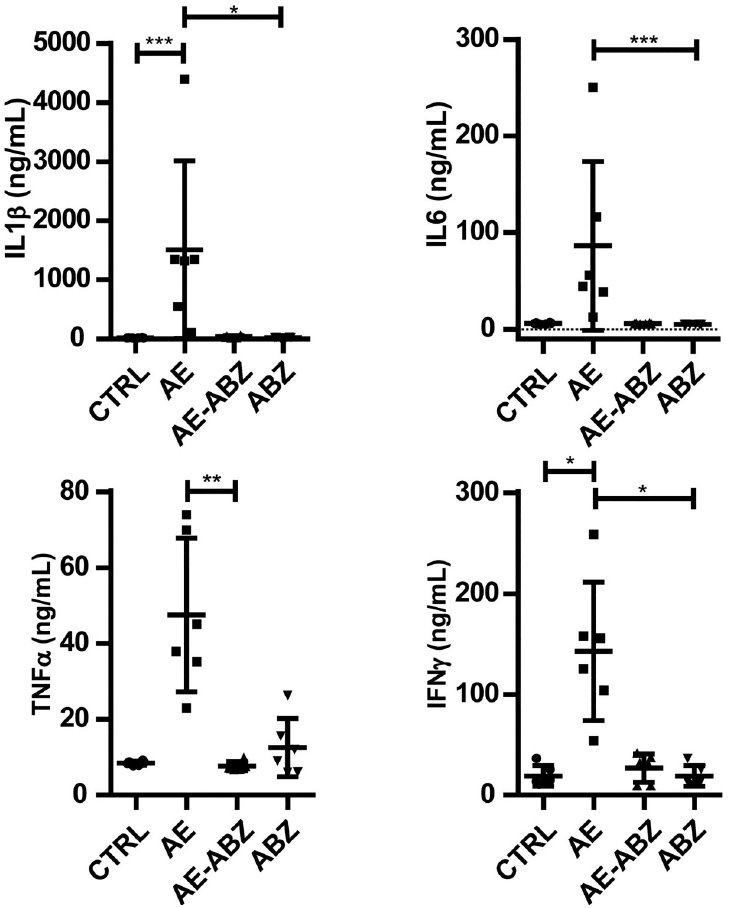
E . multilocularis infected mice (AE), infected mice treated with ABZ (AE-ABZ) or uninfected mice treated with ABZ (ABZ) (animals per group n = 6). No outliers were detected/excluded. Non-parametric, Kruskal-Wallis test followed by Dunn’s Multiple Comparison post-test. � P � 0.05; �� p � 0.01; ��� p �